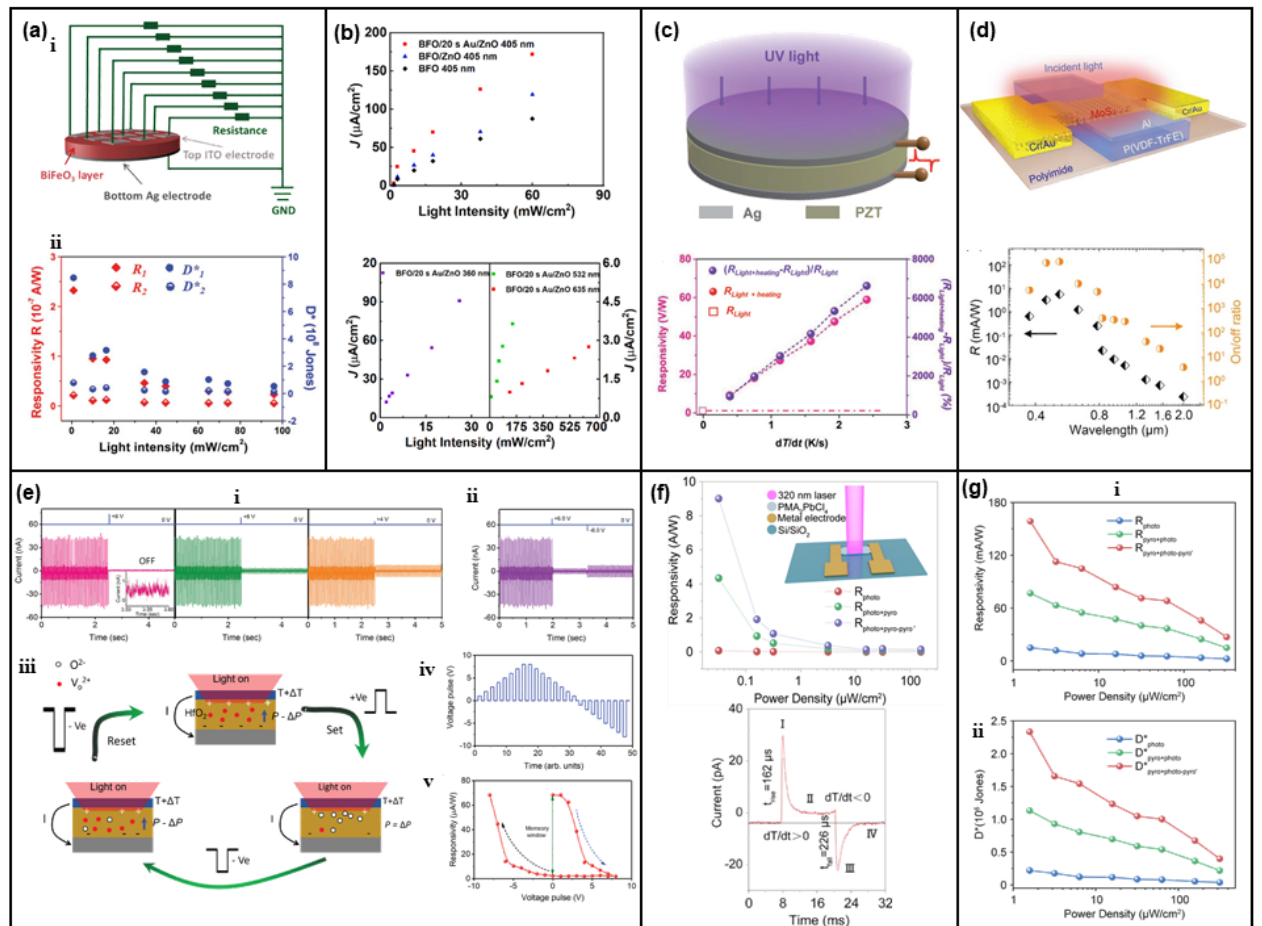
Figure 14. ( a ) ITO/BiFeO 3 /Ag photodetector. ( i ) Schematic diagram of the structure of 3 × 3 ITO/BiFeO 3 /Ag photodetector array; ( ii ) Responsivity and detectivity on the light intensity with regard to photovoltaic–pyroelectric coupled effect and photovoltaic effect based on ITO/BiFeO 3 /Ag photodetector. Reproduced with permission from [105]. Copyright 2017 Wiley; ( b ) Light intensity dependence of photocurrent density of BiFeO 3 films, BiFeO 3 /ZnO, and BiFeO 3 /20 s Au/ZnO het- erostructures under 405, 360, 532, and 635 nm light illumination at zero bias. Reproduced with permission from [106]. Copyright 2021 Elsevier; ( c ) Schematic diagram of Ag/PZT/Ag device and dependence of responsibility on the temperature change rate dT/dt, as well as the corresponding enhancement when Ag/PZT/Ag device, respond to 365 nm light in a heating state. Reproduced with permission from [107]. Copyright 2017 Wiley; ( d ) 3D schematic of the photodetector con- structed by a hybrid quasi-freestanding structure of organic ferroelectric poly(vinylidene fluoride– trifluoroethylene) with MoS 2 , photoresponsivity, and on/off photocurrent switching ratio of the photodetector for incident light wavelengths ranging from 375 nm to 2 µ m at V SD = 1 V. Repro- duced with permission from [108]. Copyright 2019 Wiley; ( e ) Pyro-phototronic memory based on HfO 2 -based self-powered infrared pyroelectric sensor. ( i ) The transient pyro-photoresponse of the device with continuous light pulse illumination before and after applying an electric pulse; ( ii ) The transient pyro-photoresponse of the device with applied positive and negative pulses of the same magnitude; ( iii ) Working mechanism; ( iv ) Shape of the applied voltage; ( v ) The change of the pyro- photoresponsivity with following the electric pulses as shown in ( iv ). Reproduced with permission from [109]. Copyright 2022 Wiley; ( f ) Ferro-pyro-phototronic effect in monocrystalline 2D ferroelectric perovskite for high-sensitive, self-powered, and stable ultraviolet photodetector. Reproduced with permission from [110]. Copyright 2022, American Chemical Society; ( g ) UV